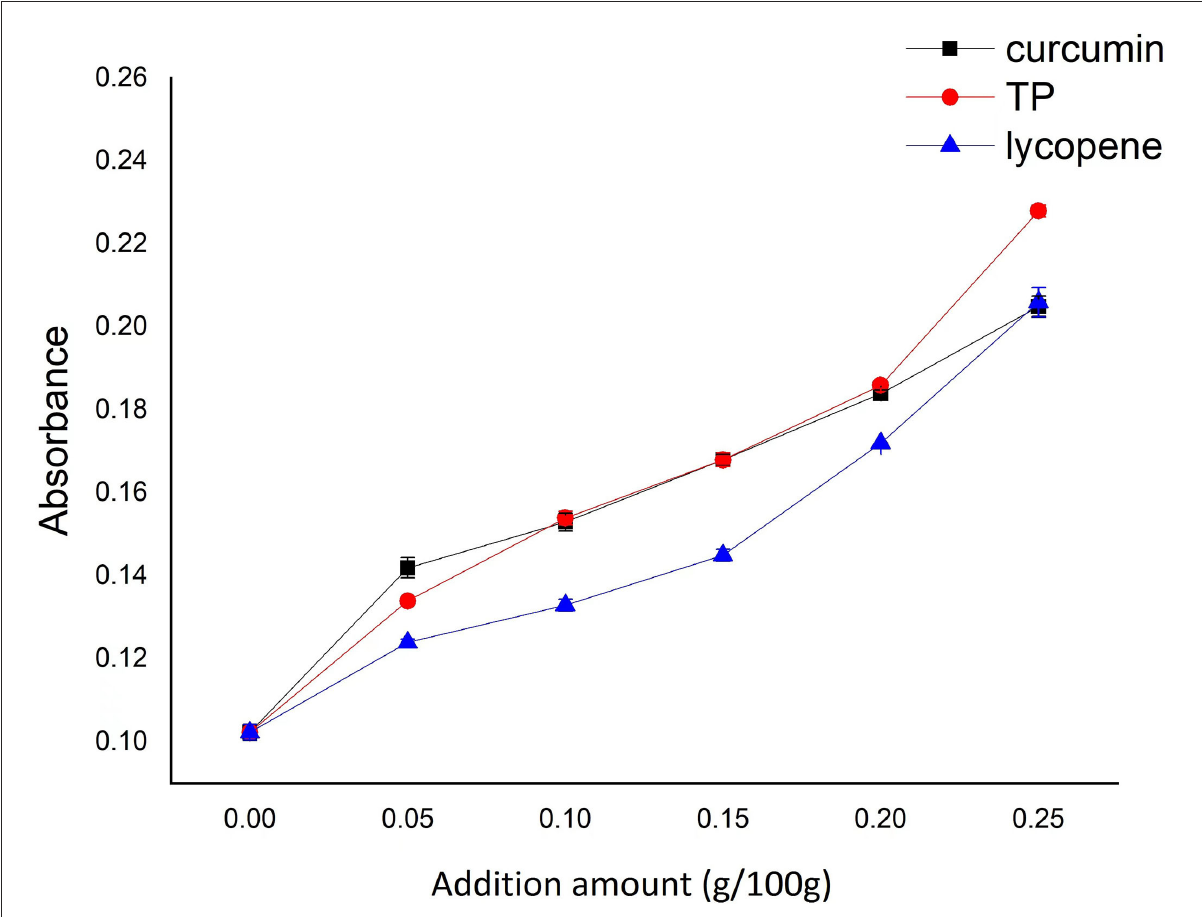
FIGURE2 Effect of additional amount of NAs on iodine blue value of the soup of boiled NASNs.